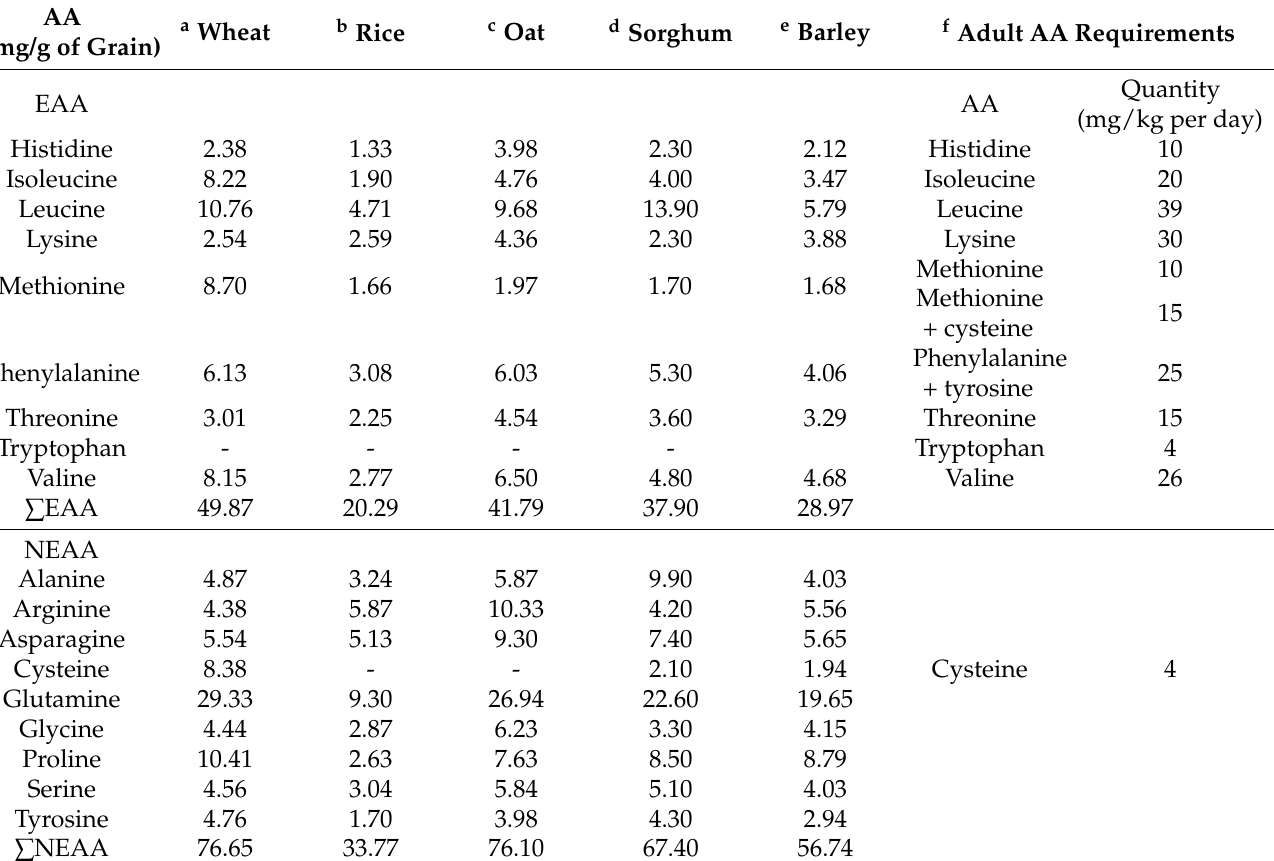
Table 1. Amino acid composition of the main cultivated cereals and comparison with the daily requirements of amino acids stipulated by the